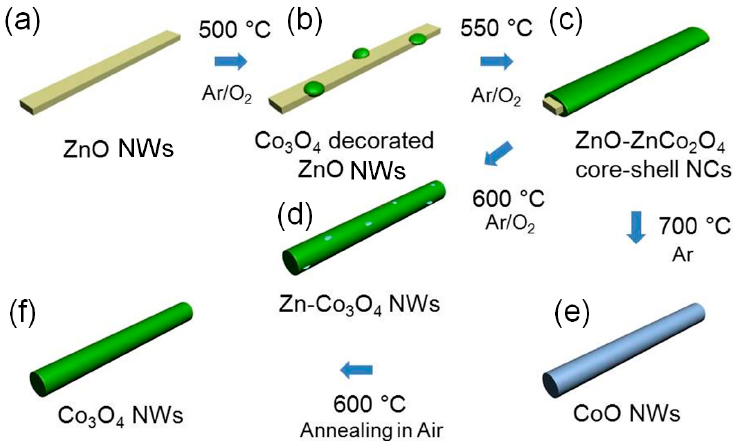
Figure 7. A schematic illustration of the transformation from ZnO NW to CoO NW and Co 3 O 4 NW. Adapted from [105] with permission. Copyright (2012) The Royal Society of Chemistry.